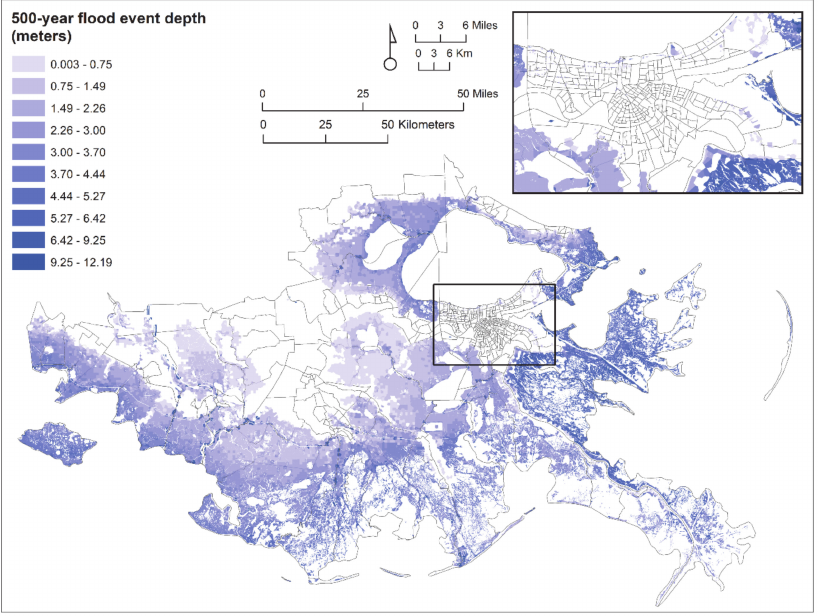
Figure 4. Extent and magnitude of coastal flooding for a 500-year flood event in the Mississippi Delta. Flood data is from Coastal Protection and Restoration Authority (CPRA) (2017) [34] and census tract data from (US Census, 2016)